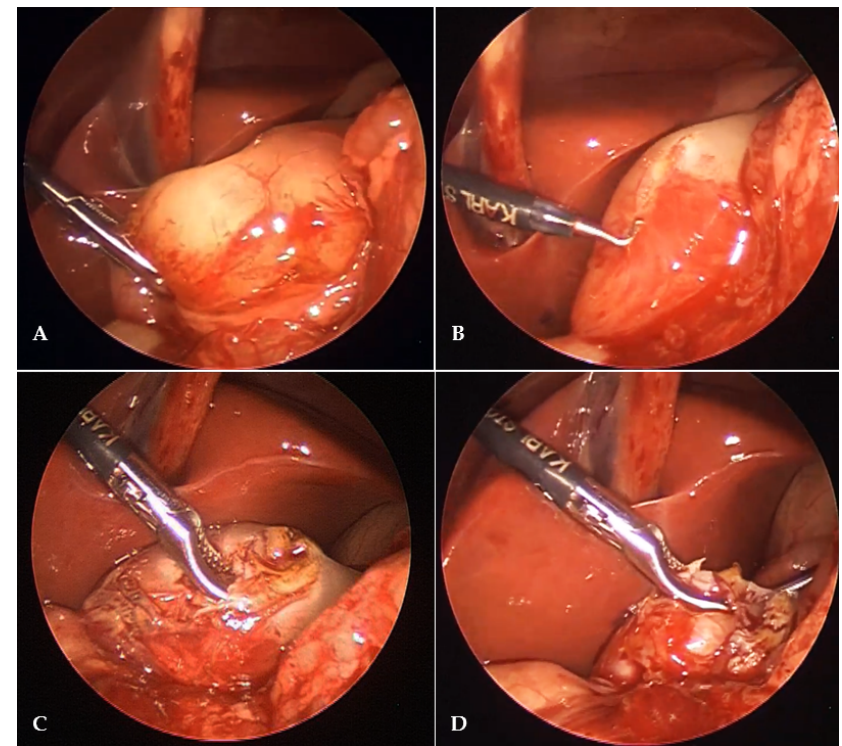
Figure 1. Intraoperative finding in 14-day-old male infant with hypertrophic pyloric stenosis who received laparoscopic pyloromyotomy: ( A ) Laparoscopic view of hypertrophied pylorus; ( B ) pyloromiotomy using 3-mm diathermy hook; ( C ) separation of the pyloric muscle layer by blunt dissection; ( D ) end of the procedure, mucosa clearly protrudes trough the incision.